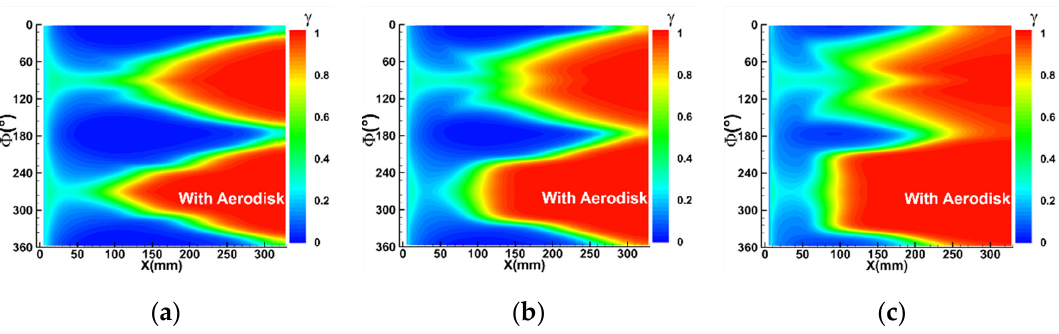
Figure 19. Distributions of γ with aerodisks at α = 2°,4°,6°. ( a ) α = 2°, ( b ) α = 4°, ( c ) α = 6°.